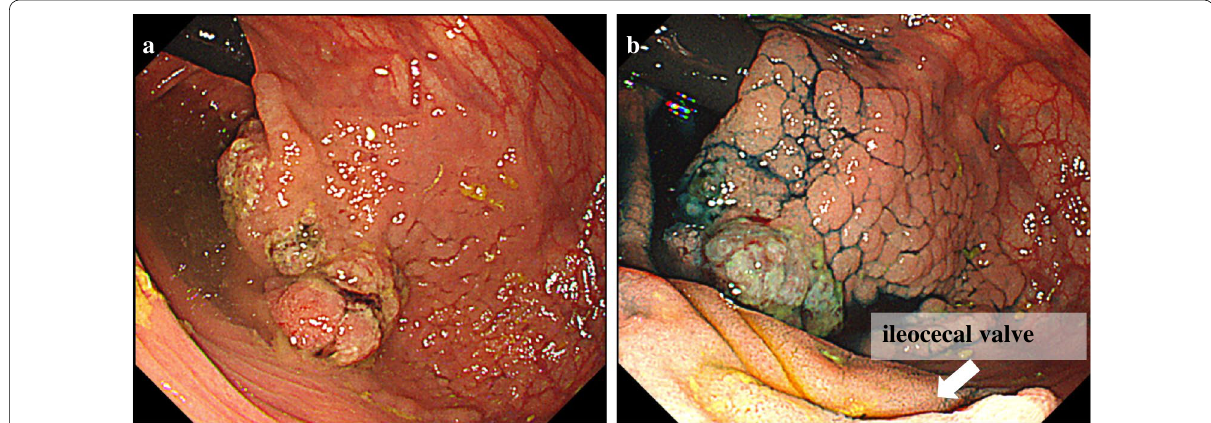
Fig. 1 Colonoscopy images showing view from the cecum side to the ascending colon ( a , b ). A laterally spreading tumor is clearly visible with indigo carmine staining ( b